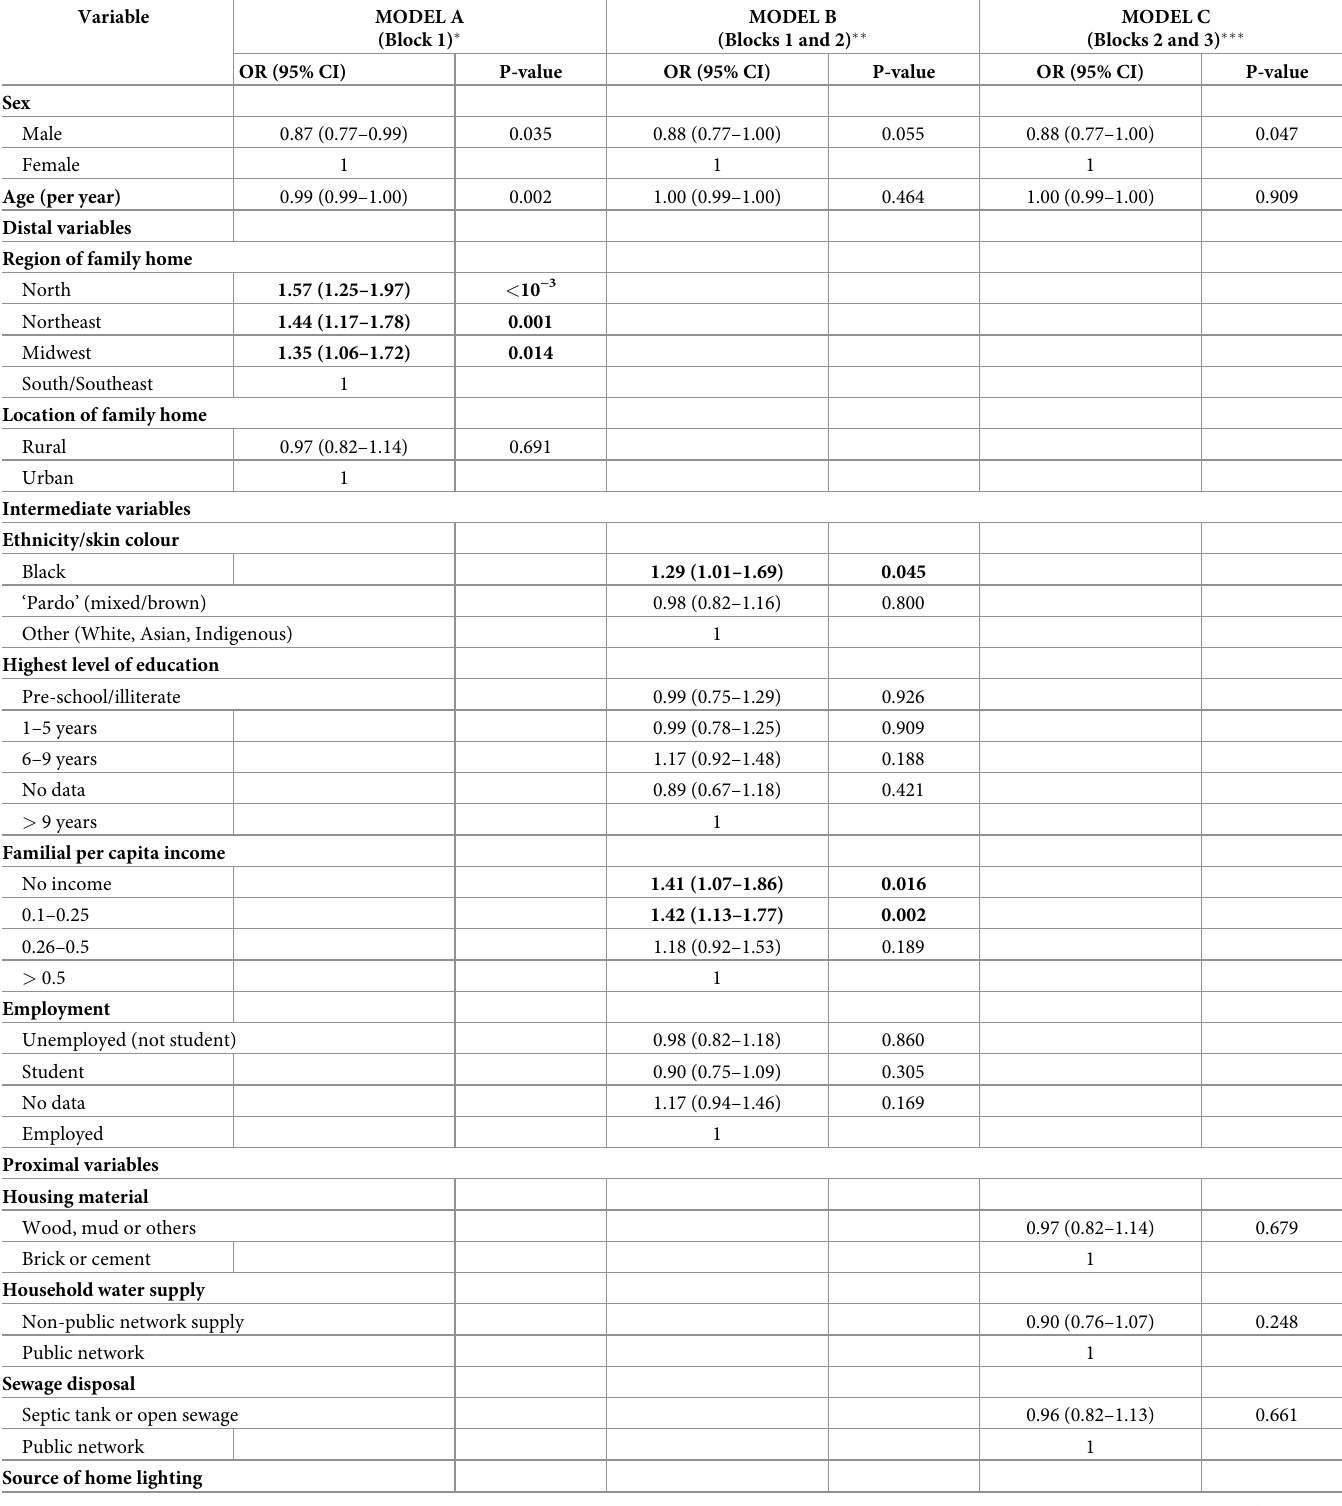
Table 2. Results from multivariate hierarchical analysis of the association of geographic and socioeconomic factors with leprosy treatment default (N = 20,063), Brazil,